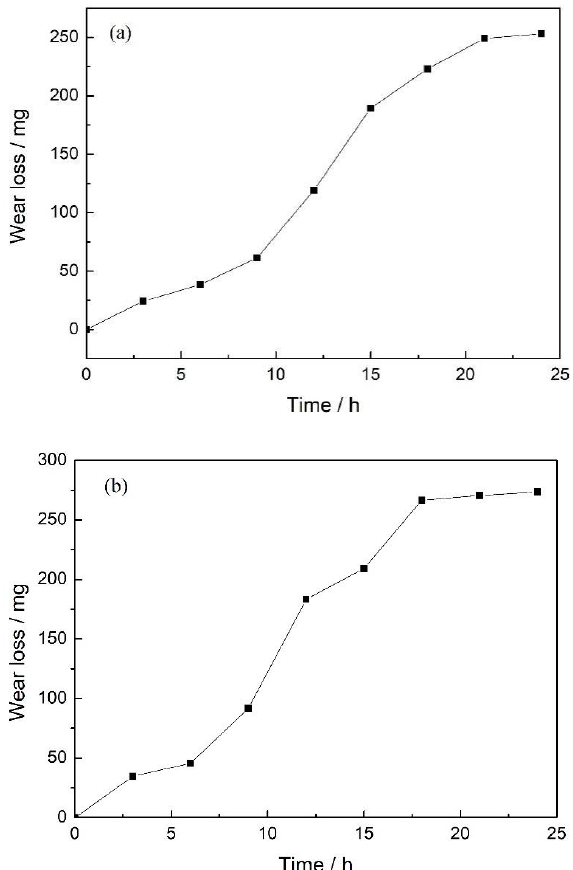
Figure 6. Wear loss of sliding bearing along with time. ( a ) Case 1 and ( b ) Case